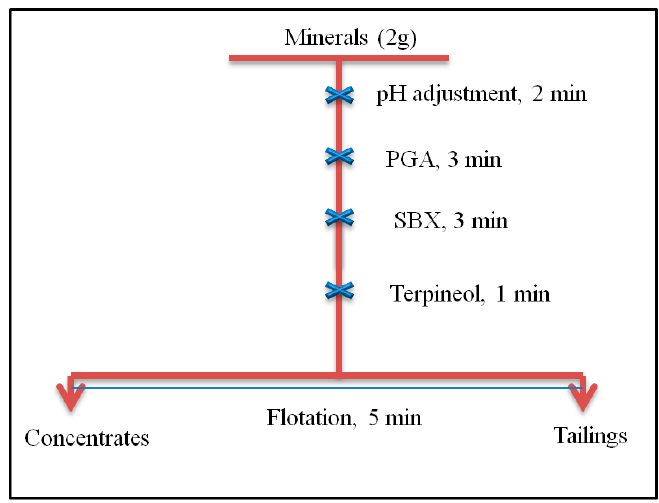
Figure 3. Adopted procedure for single and binary mineral selective flotation experiments.